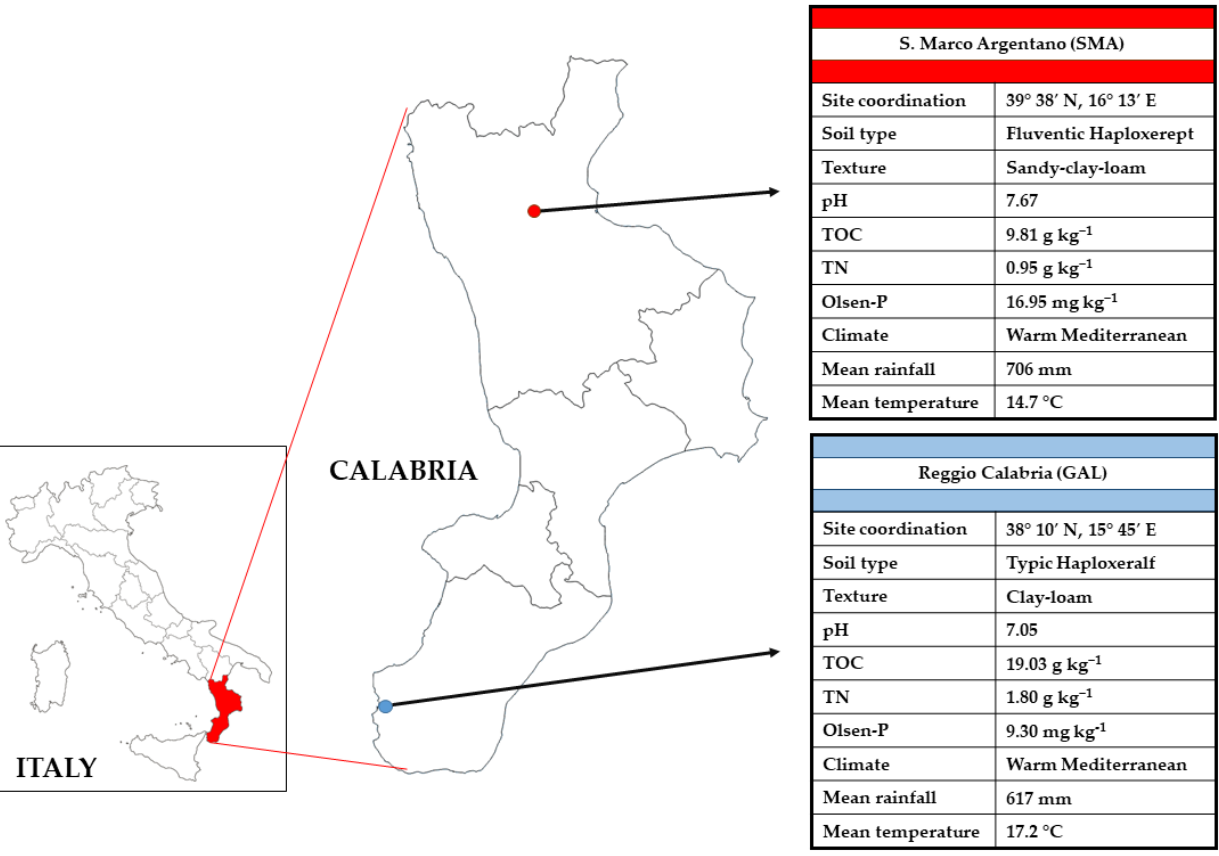
Figure 1. Overview of the two experimental sites: the first located at Reggio Calabria (GAL) (blue frame) and the second one at S. Marco Argentano (SMA) (red frame). Onset tables show geographic coordination reference, major soil data and soil taxonomy, climate classification, mean annual rainfall, and temperature.